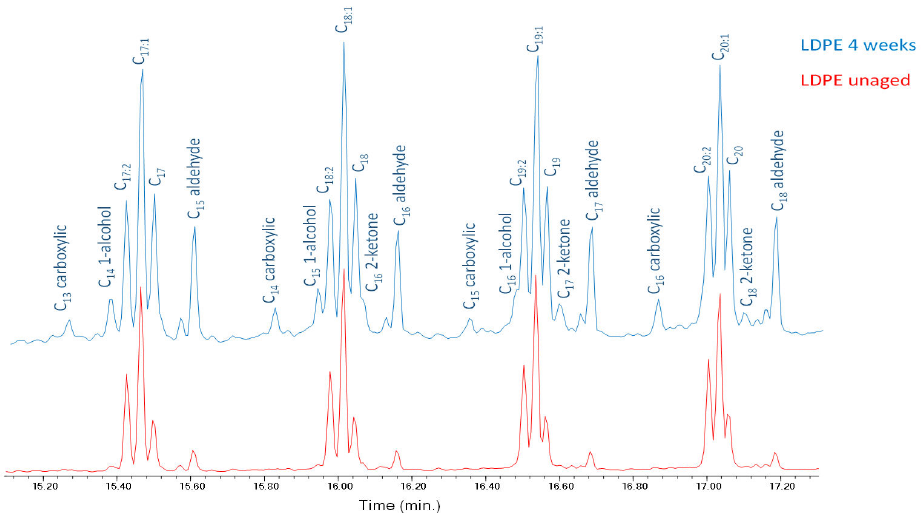
Figure 8. Chromatograms (15.20–17.20 min) obtained in the Py–GC–MS analysis of LDPE-0w (red) and LDPE-4w (blue). C n:2 refers to α , ω -dienes, C n:1 to 1-alkenes, and C n to alkanes of a hydrocarbon with n carbon